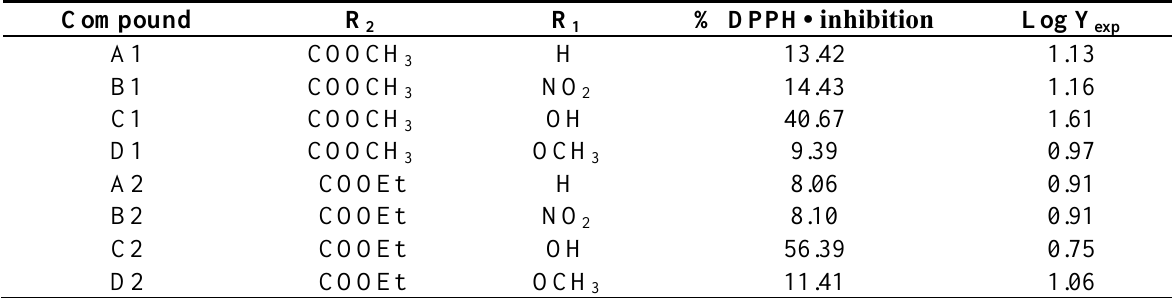
Table 1. Coumarin compounds and their experimental antiradical activity expressed as equivalents in % DPPH• inhibition.